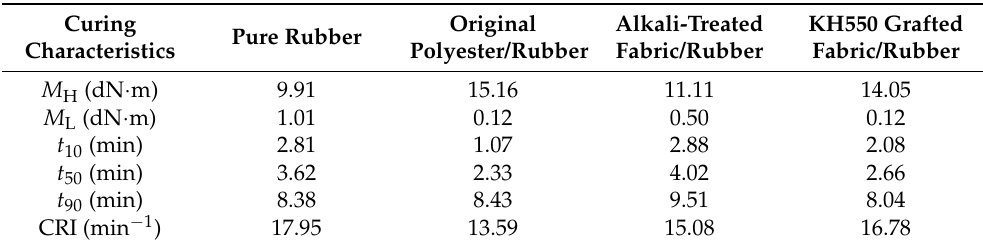
Figure 8. Vulcanization curves of samples (Pure rubber, Pure fabric/rubber, 2 wt% alkali-treated fabric/rubber, KH550 grafted fabric/rubber). Table 1. Vulcanization parameters of samples (Pure rubber, Pure fabric/rubber, alkali-treated fab- ric/rubber, KH550 grafted